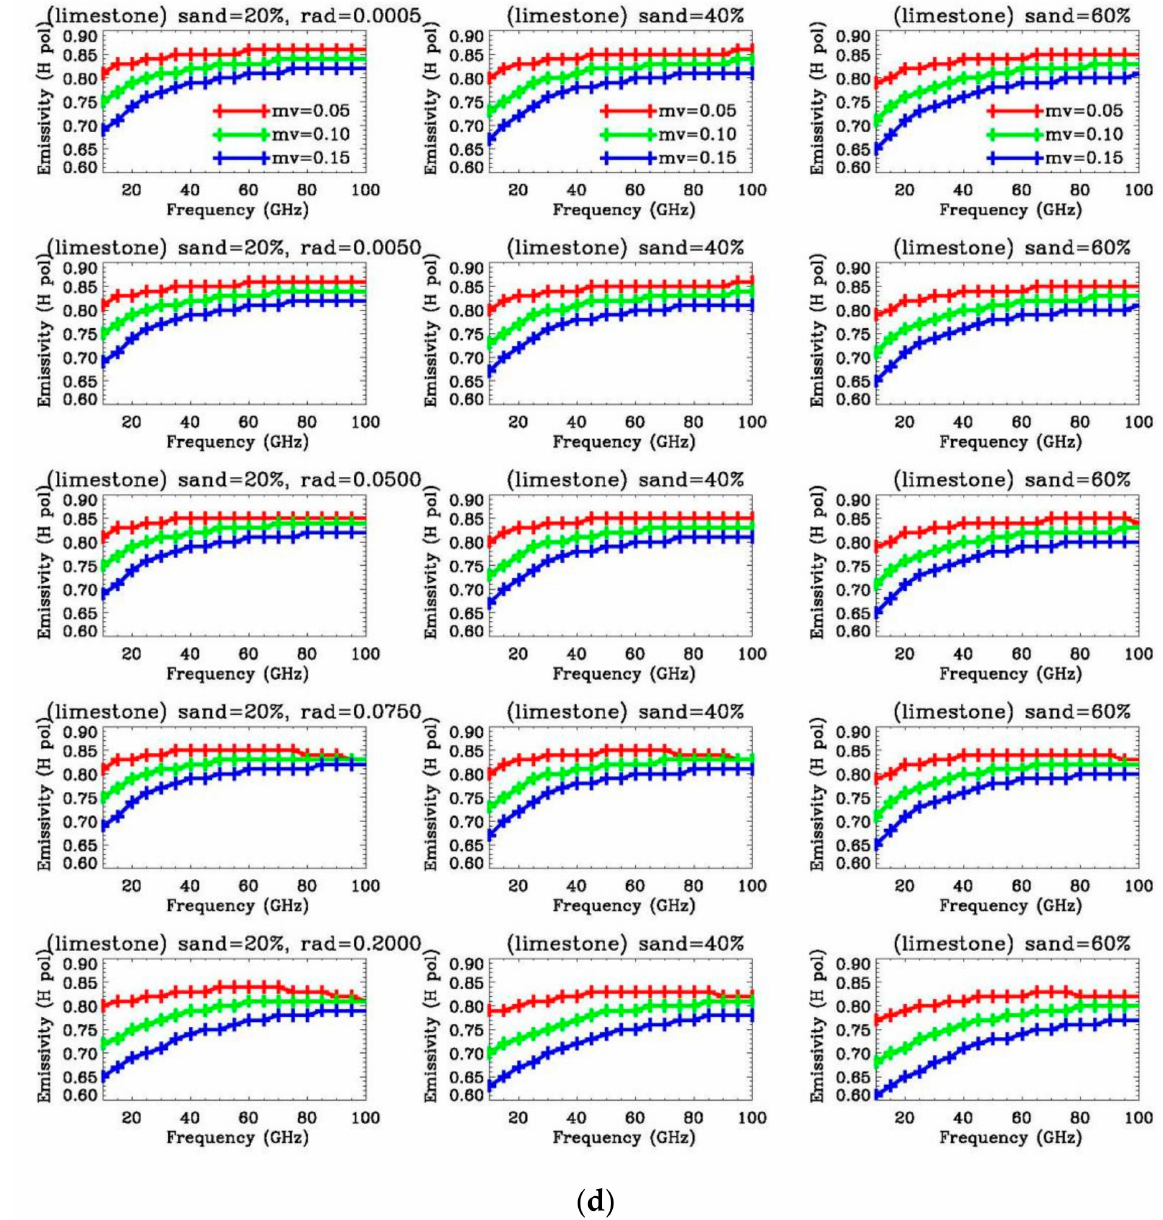
Figure 4. MLEM modeled emissivity spectra from different minerals with different distributions of particle size, sand fraction, and soil moisture: ( a ) quartz; ( b ) sandstone; ( c ) granite; ( d )